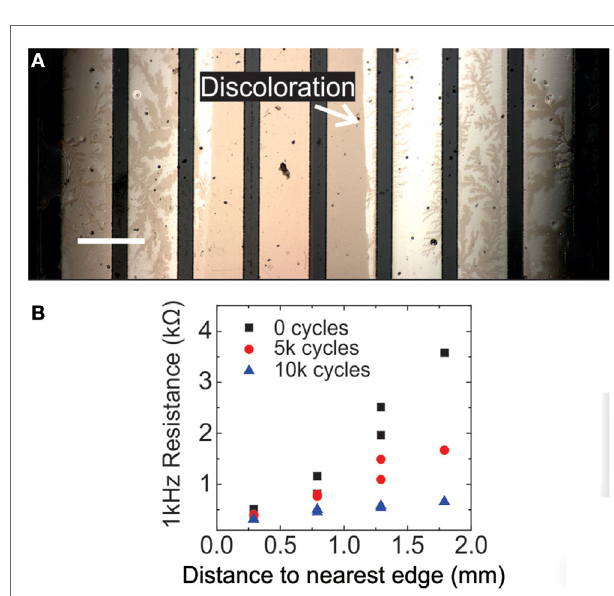
FigUre 15 | (a) Micrograph of all eight traces of a PMAP device showing discoloration and branched patterns occurring on outside traces (scale bar is 500 μ m). (B) The transverse impedance at 1 kHz for the traces shown in ( a) versus their proximity to the edge. Before bend testing, traces closest to the edge had the lowest impedance, but this difference decreased as the device was exposed to more bend cycles.